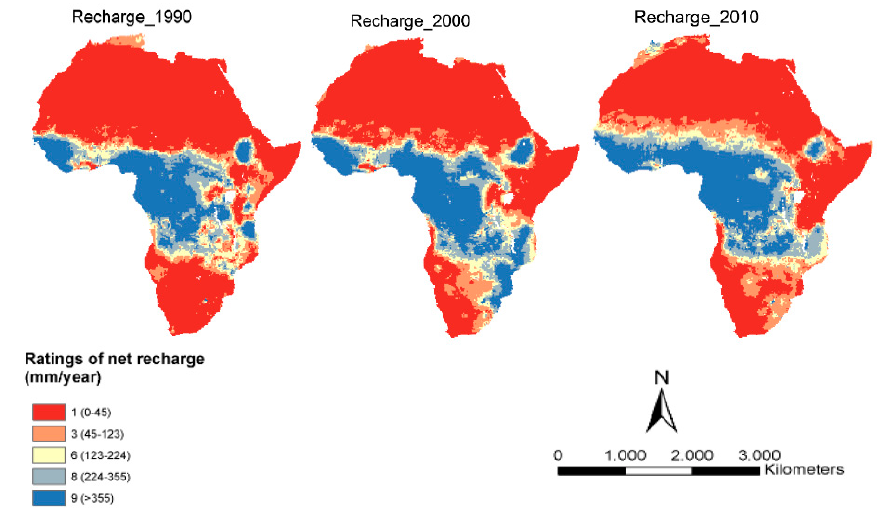
Figure 2. Rating of recharge ( R ) map in Africa for 1990, 2000, and 2010.